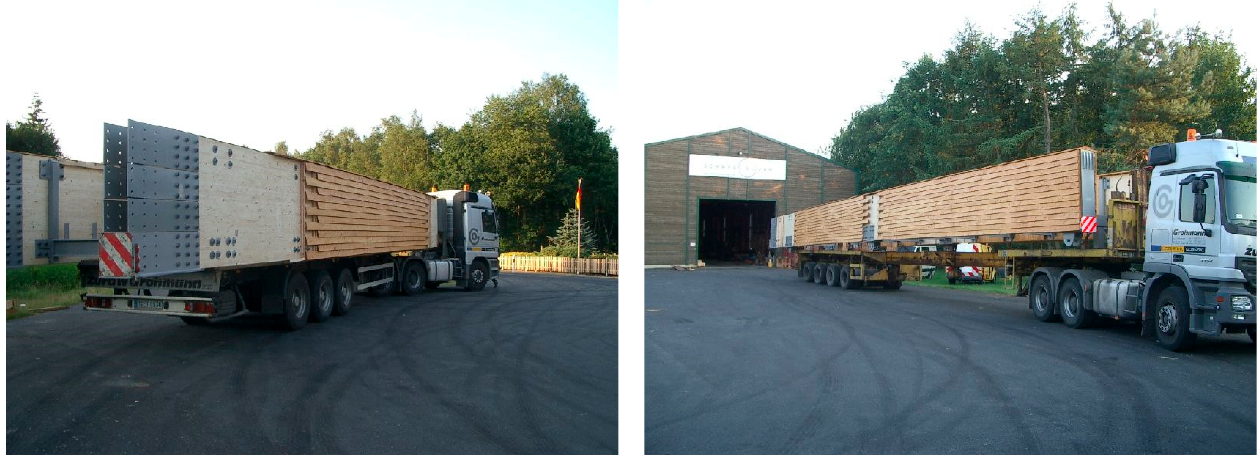
Figure 4. Assembling segments of the deck during their transport on the specialized lorries from the woodworking company in Germany to the construction site in Poland (Photos credit: Schmees & Lühn Holz- und Stahlingenieurbau GmbH & Co. KG and Mosty-Wrocław Design & Research Office).